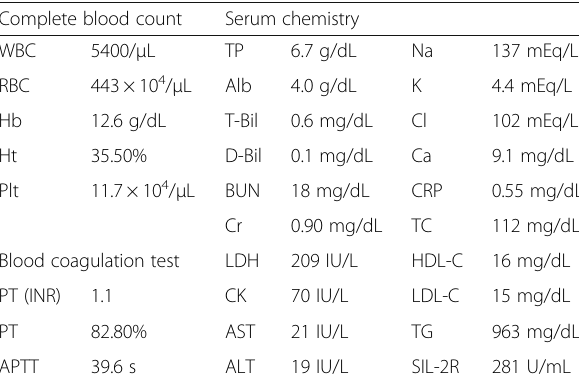
Table 1 Blood test results of the patient. Blood test results revealed hypertriglyceridemia Complete blood count